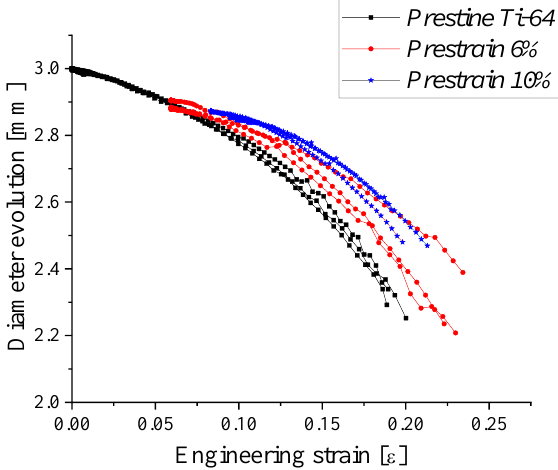
Fig. 3. Diameter reduction of the pristine and pre-strain Ti-64 cylindrical